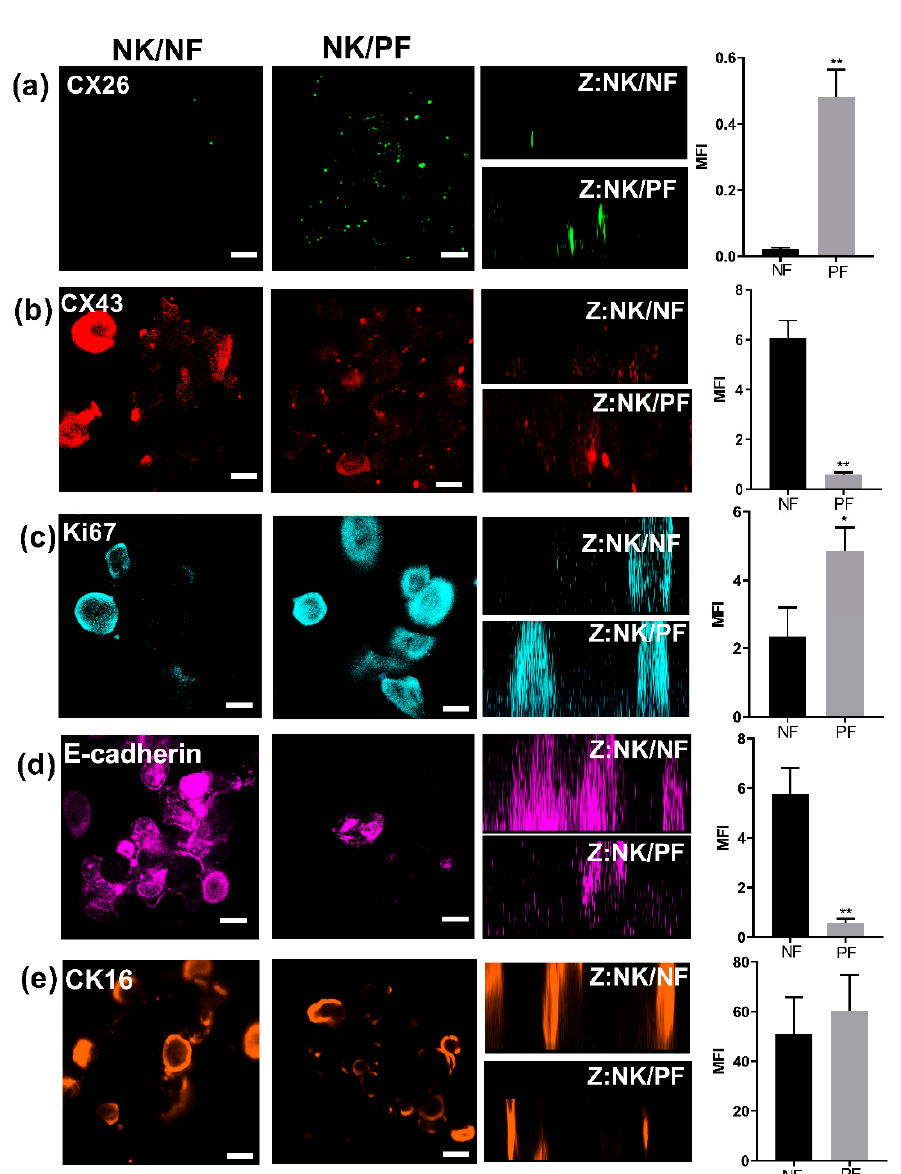
Figure 5. 3D Organotypic epidermal model. Keratinocytes grown in transwells on either a normal (column NK/NF) or on a psoriatic (column NK/PF) fibroblast feeder layer were fixed and stained after 12 days at the ALI with relevant antibodies followed by 3D z-stack reconstruction (Z: NK/NF). IHC analysis determined expression of ( a ) CX26, ( b ) CX43, ( c ) Ki67, ( d ) E-cadherin and ( e ) CK16 protein expression. ( a – e ) bar = 100 µ m. The mean fluorescent intensity of multiple regions from different cultures was extracted (right hand panel). Statistical analysis was performed by Student t -test N = 3. * p < 0.05; ** p < 0.001.